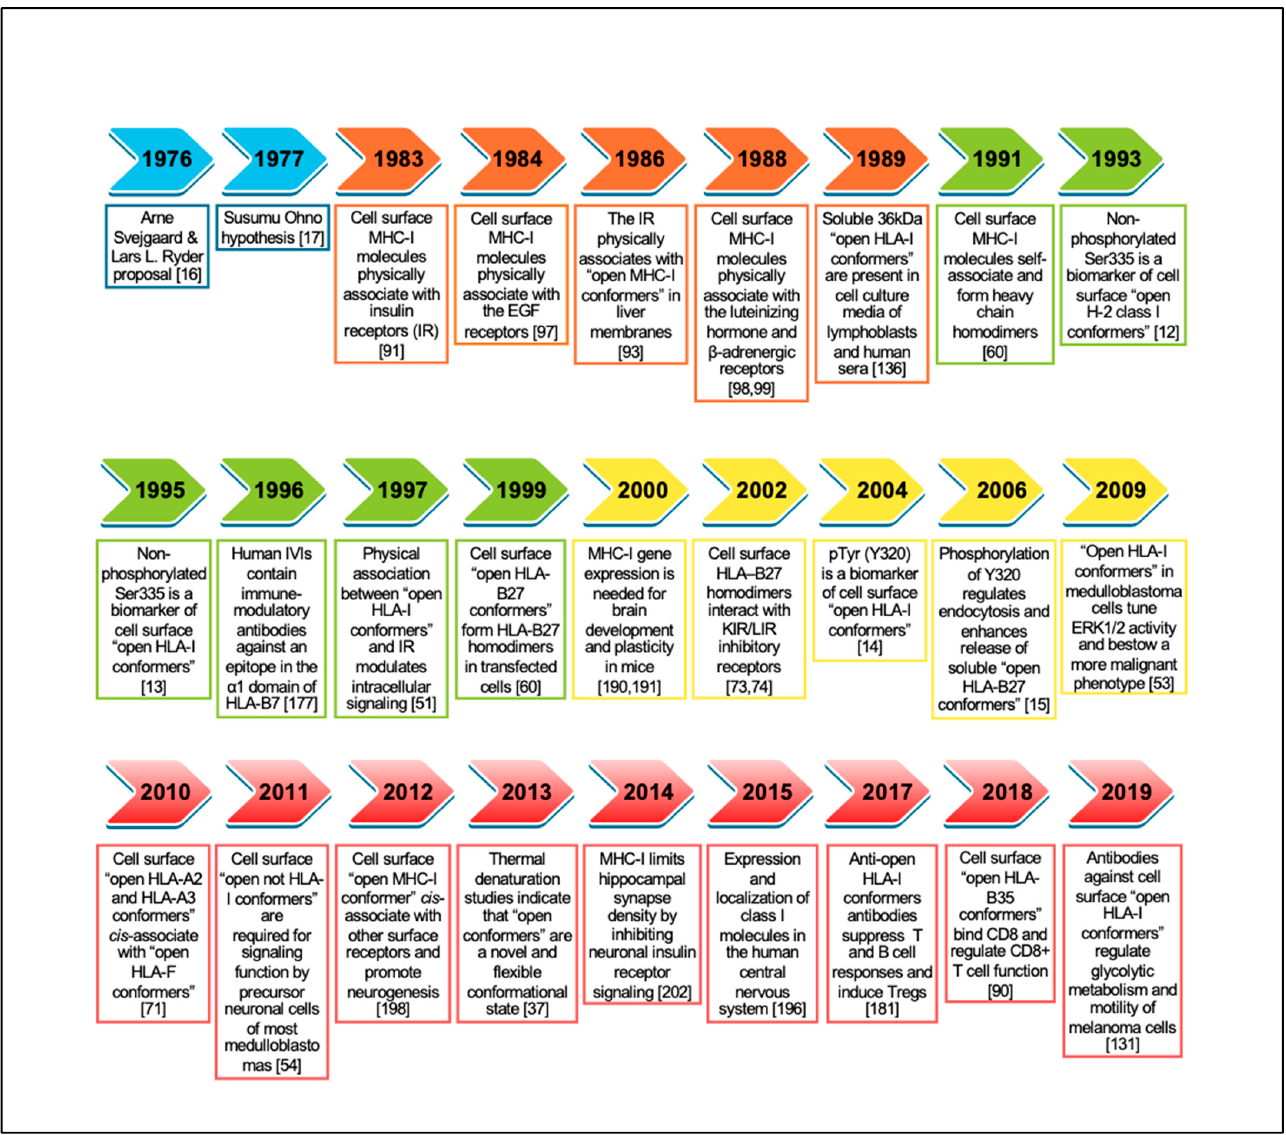
Figure 2. Timeline of representative studies contributing to the understanding of the biology of cell surface open MHC-I conformers. Initial hypotheses highlighted in blue. References for each hallmark are included between parentheses.